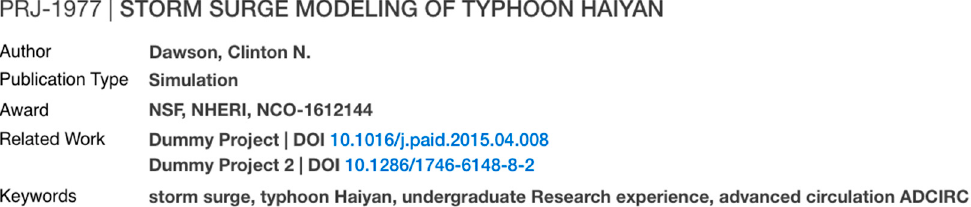
Figure 10. Related Work element in the landing page allows to associate external and local data sources, bibliographic citations, or projects. The element does not show if no related works are added to the project.